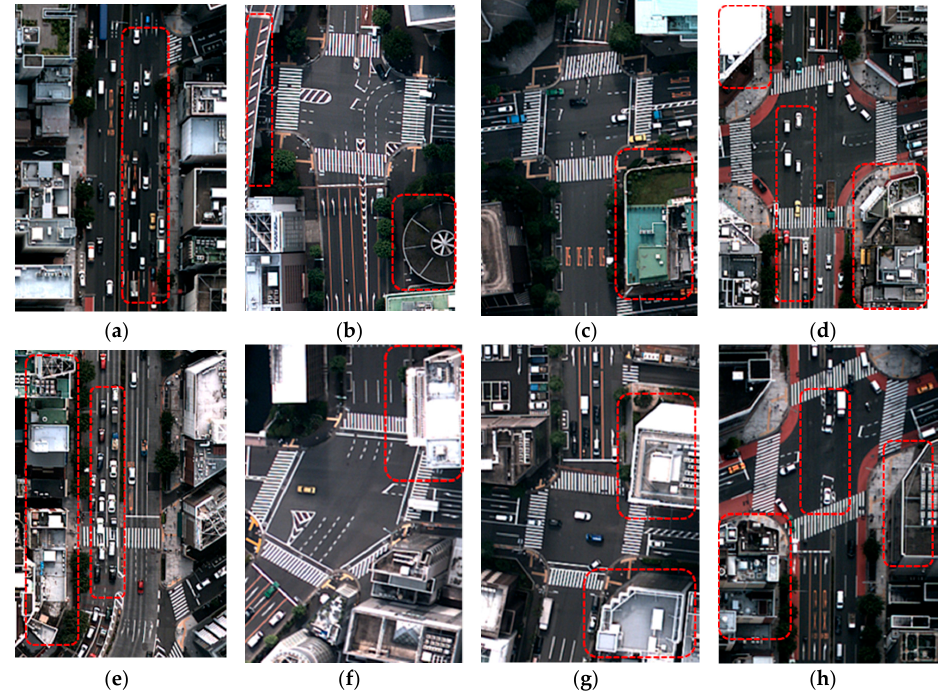
Figure 3. Sample road markings in the aerial images of the Hitotsubashi area in central Tokyo. Some of the problematic areas are highlighted by the red dotted rectangles.